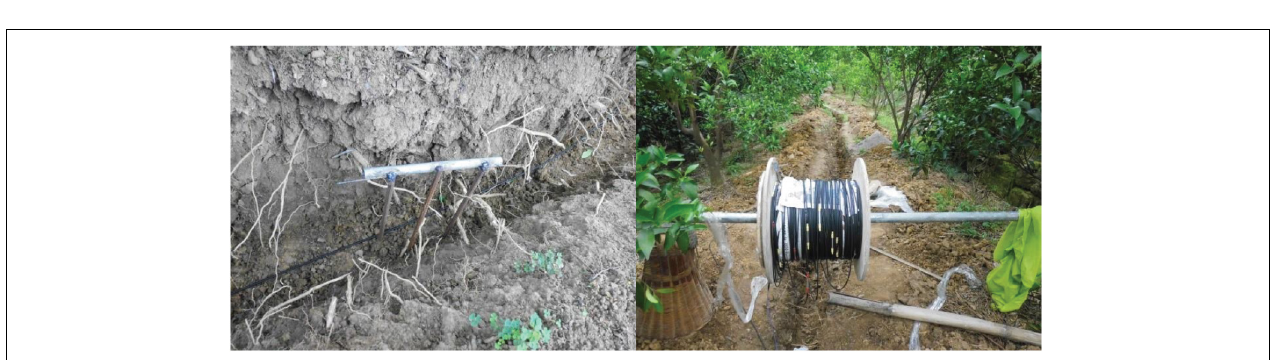
FIGURE 3 | Engineering geological profile of the Baishuihe Landslide.